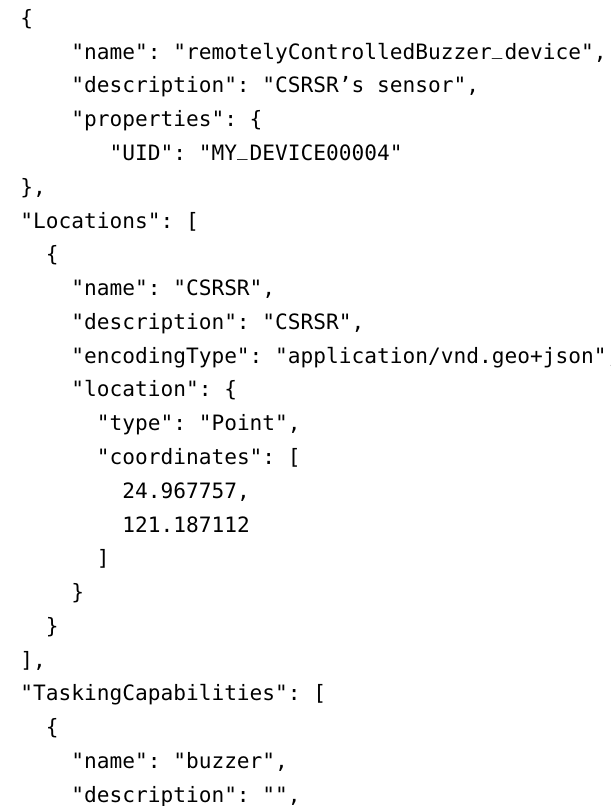
Algorithm A4. The description file of the remotely-controllable buzzer